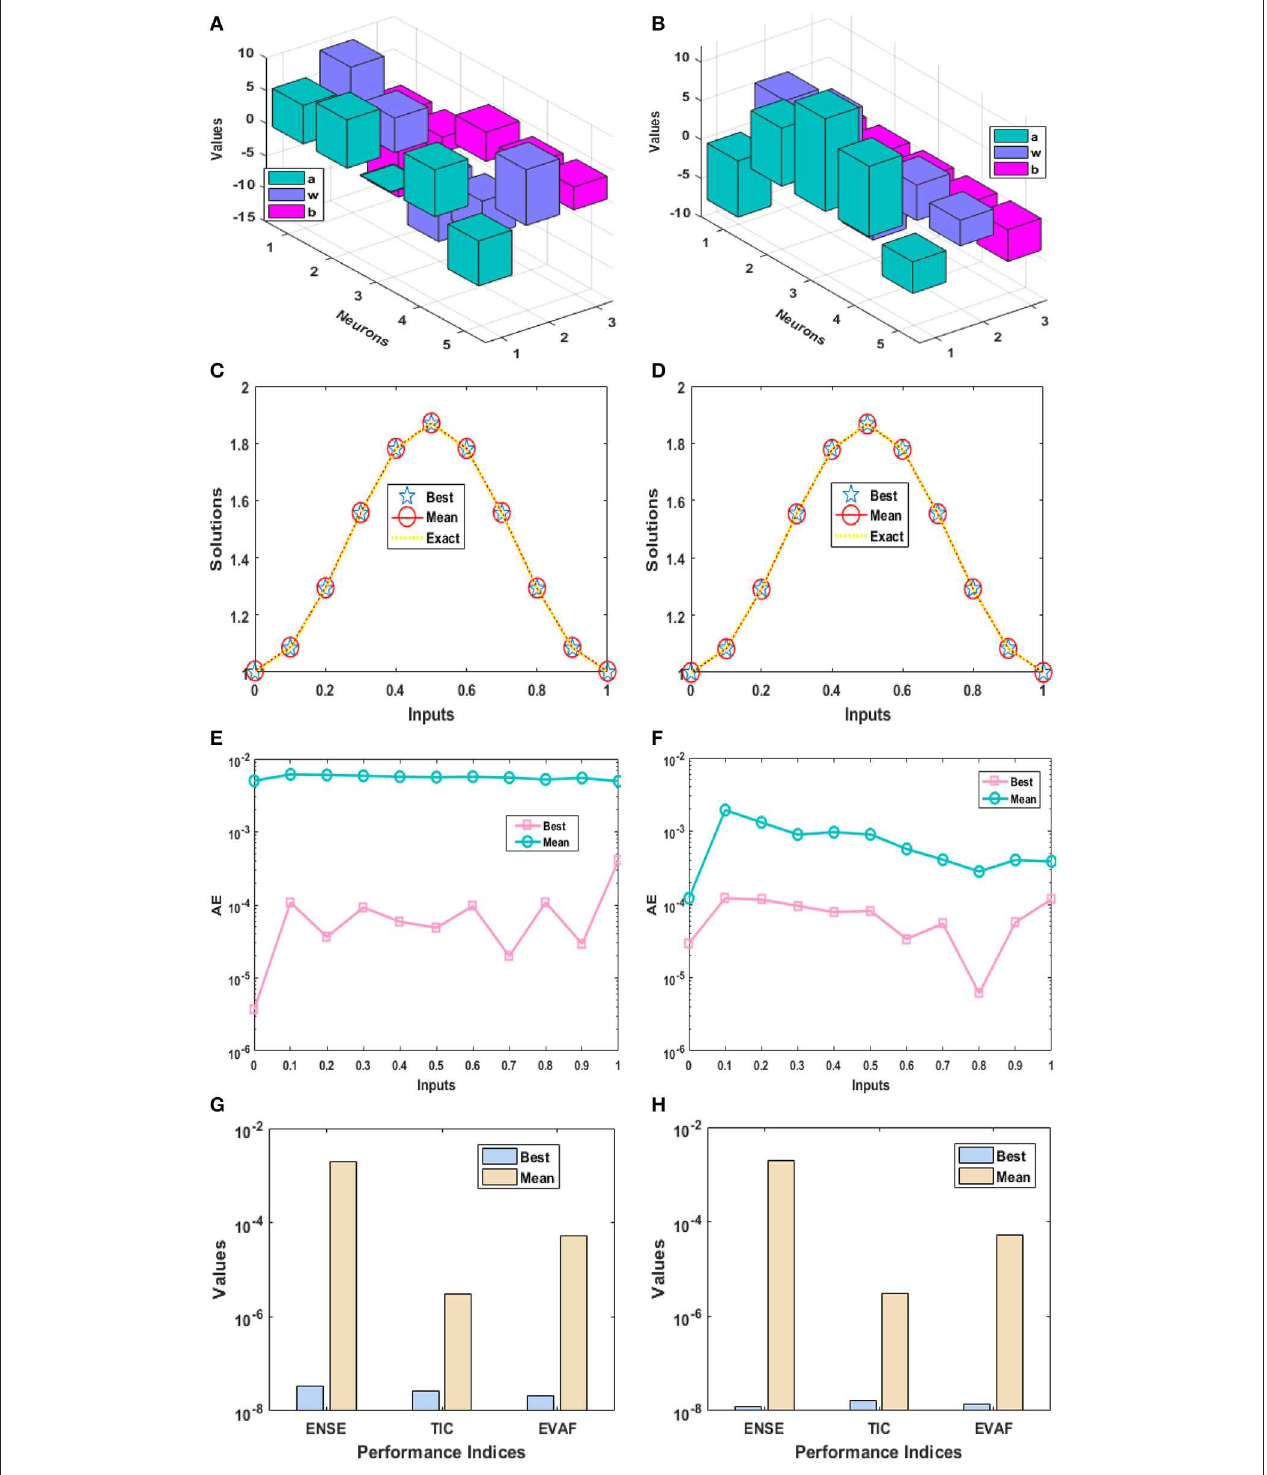
FIGURE 1 | Best weight, results of the designed methodology, values of the AE, and performance measures of Examples 1 and 2 for 5 numbers of neurons. (A) ANN best weights for Example 1. (B) ANN best weights for Example 2. (C) Result comparison for Example 1. (D) Result comparison for Example 2. (E) AE values for Example 1. (F) AE values of for Example 2. (G) Performance measures for Example 1. (H) Performance measures for Example 2.